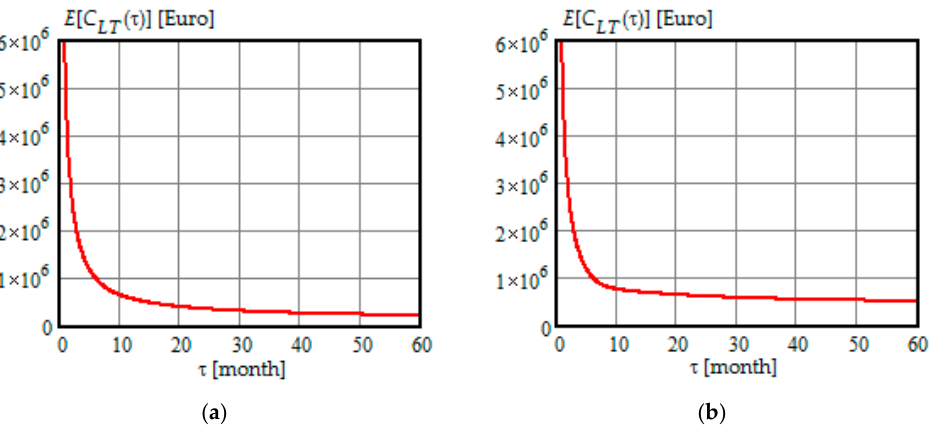
Figure 12. The dependence of the average lifetime maintenance cost on the periodicity of predetermined preventive maintenance when C UF = 0: ( a ) Initiation crack rate is 0.05 [1 / year]; ( b ) Initiation crack rate is 0.2 [1 / year].